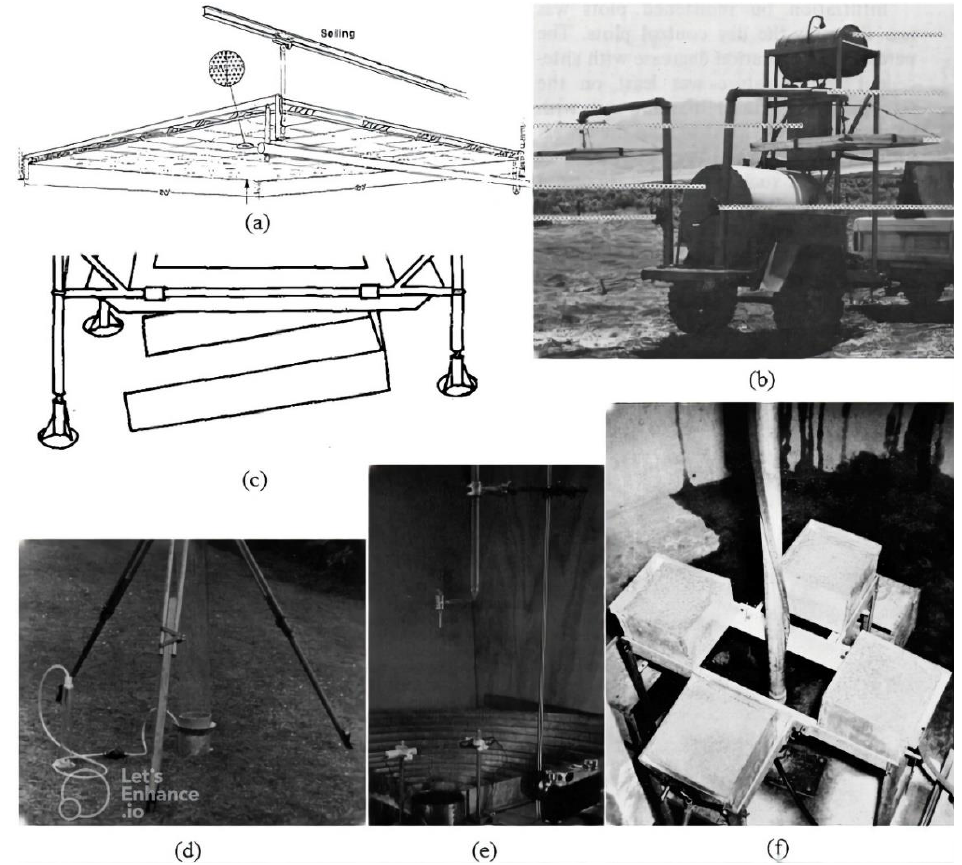
Figure 1. Six examples of simulators structural support: ( a ) Structural support attached to the laboratory ceiling [54] (Reprinted/adapted with permission from Ref. [Israelsen et al., 1979]); ( b ) Structural support attached to an off-road vehicle [64] (Reprinted/adapted with permission from Ref. [Epstein & Grant, 1966]); ( c ) Four-legged simulator support [50] (Reprinted/adapted with permission from Ref. [Munn & Huntington, 1976]); ( d ) Three-legged simulator support [39] (Reprinted/adapted with permission from Ref. [Tricker, 1979]); ( e ) Structural support of DRS =1 [65] (Reprinted/adapted with permission from Ref. [Riezebos & Epema]); ( f ) Structural support in the form of a rotating vertical pipe [63] (Reprinted/adapted with permission from Ref. [Blackburn et al., 1974]). Depending on the height of the structural support, i.e., the height at which the water tank with drippers can be placed, the drops of simulated rain can reach a certain percentage of the terminal fall velocity [9]. Most often, the heights are up to 2 m. The number of simulations with a drop height over 2 m gradually decreases to a height of 5 m. The number of simulations with drop heights over 5 m is relatively uniform, while the highest recorded drop height is 14 m (Figure